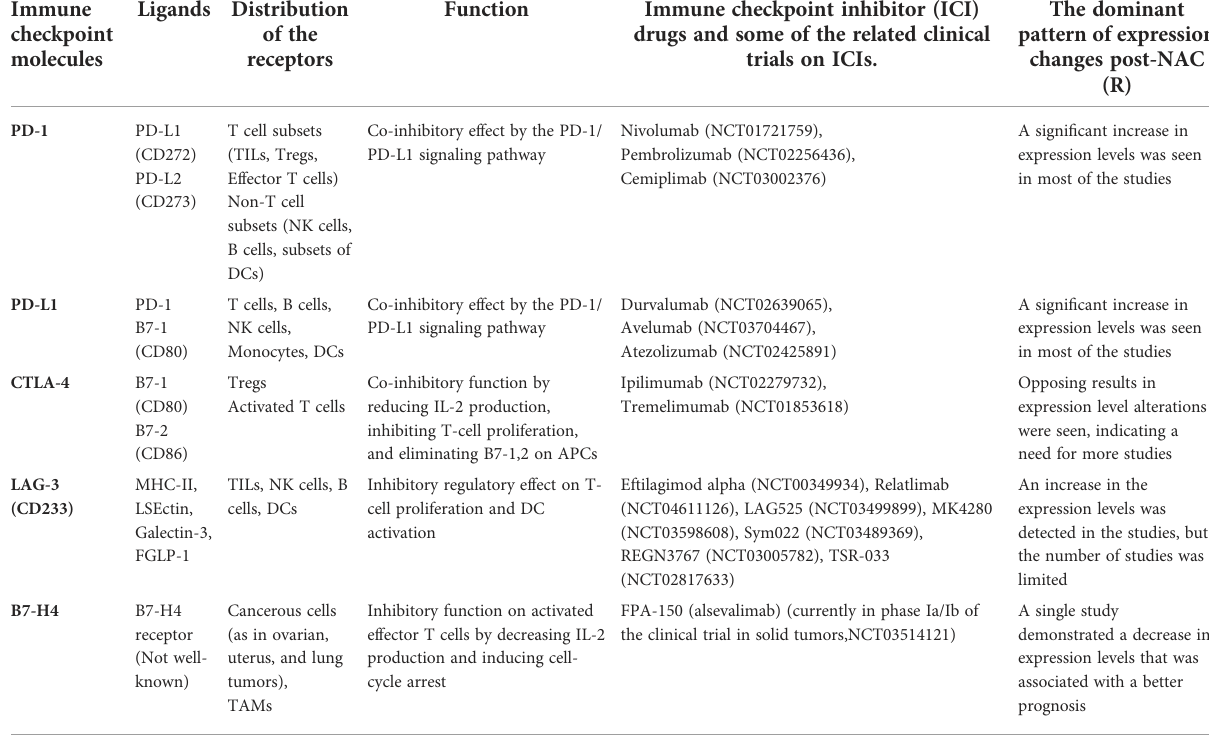
TABLE 1 A summary of the immune checkpoints and their expression changes pattern in response to chemo/radio therapy. Immune checkpoint